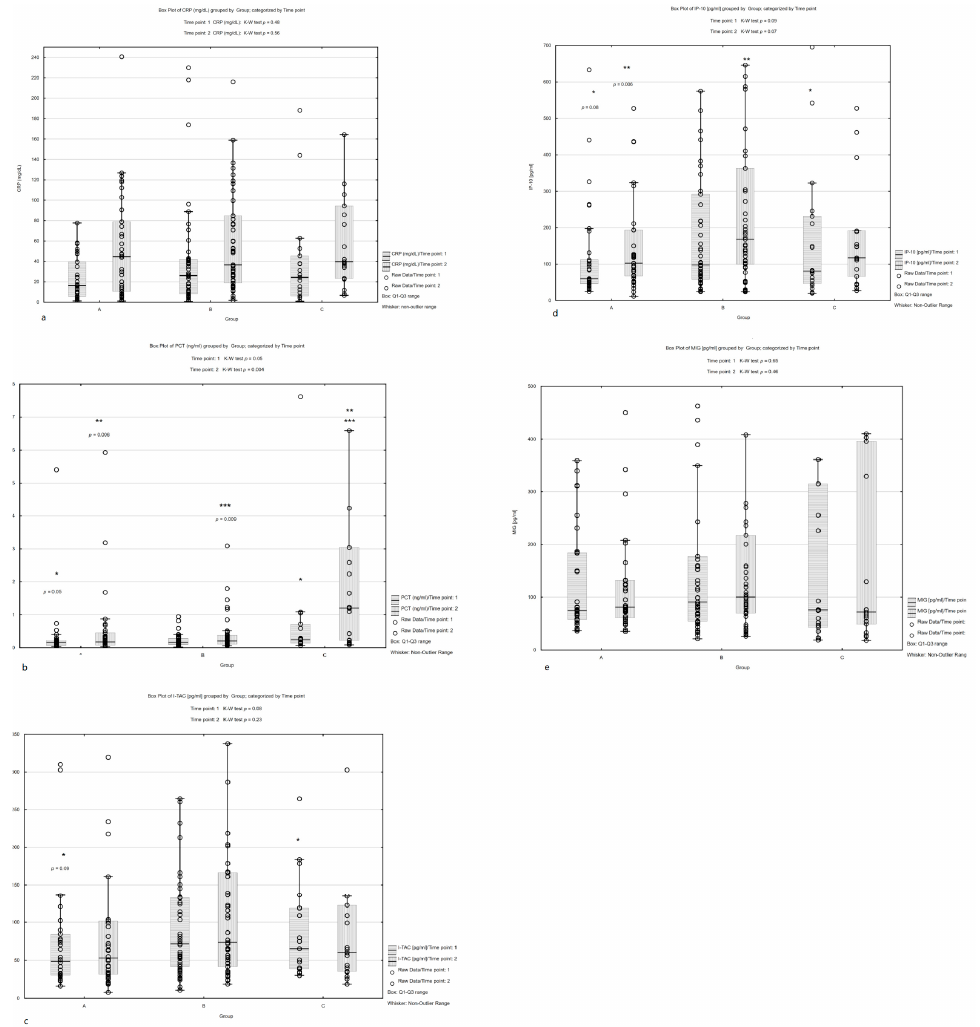
Figure 1. Comparisons of all markers’ concentrations between groups A, B and C. After combining Group B with Group C, chemokine concentrations were found to be significantly lower in Group A vs. B+C: I-TAC 1: 48.64 vs. 70.99 pg/mL, p = 0.03; IP-10 1: 59.95 vs. 96.84 pg/mL, p = 0.04; and IP-10 2: 102.40 vs. 149.39 pg/mL, p = 0.05), Figure 2. ROC curves were created for all analyzed parameters at both time points (Figure S1). The best cut-off values for distinguishing patients with a lower risk of infection (FUO, group A) from those with a higher risk (group B+C) were as follows: I-TAC 1 (<33.34 pg/mL) sen- sitivity 87.9% and specificity 41.2% (AUC 0.637, p = 0.02), IP-10 1 (<63.3 pg/mL) sensitivity 72.7% and specificity 55.9% (AUC 0.624, p = 0.003) and IP-10 2 (<129.9 pg/mL) sensitivity 57.6% and specificity 70.6% (AUC 0.623, p = 0.03) (Figure 3, Table S3). Assuming I-TAC 1 > 33.34 pg/mL as a cut-off value, 78 patients were indicated as being at high risk of severe infection, which actually occurred in 58 (74.4%) of cases, whereas only in 8 cases of the group with I-TAC 1 < 33.34 pg/mL. This resulted in OR of 5.08 (95% CI, 1.86–13.89) and RR of 2.04 (95% CI, 0.85–4.92) (Table